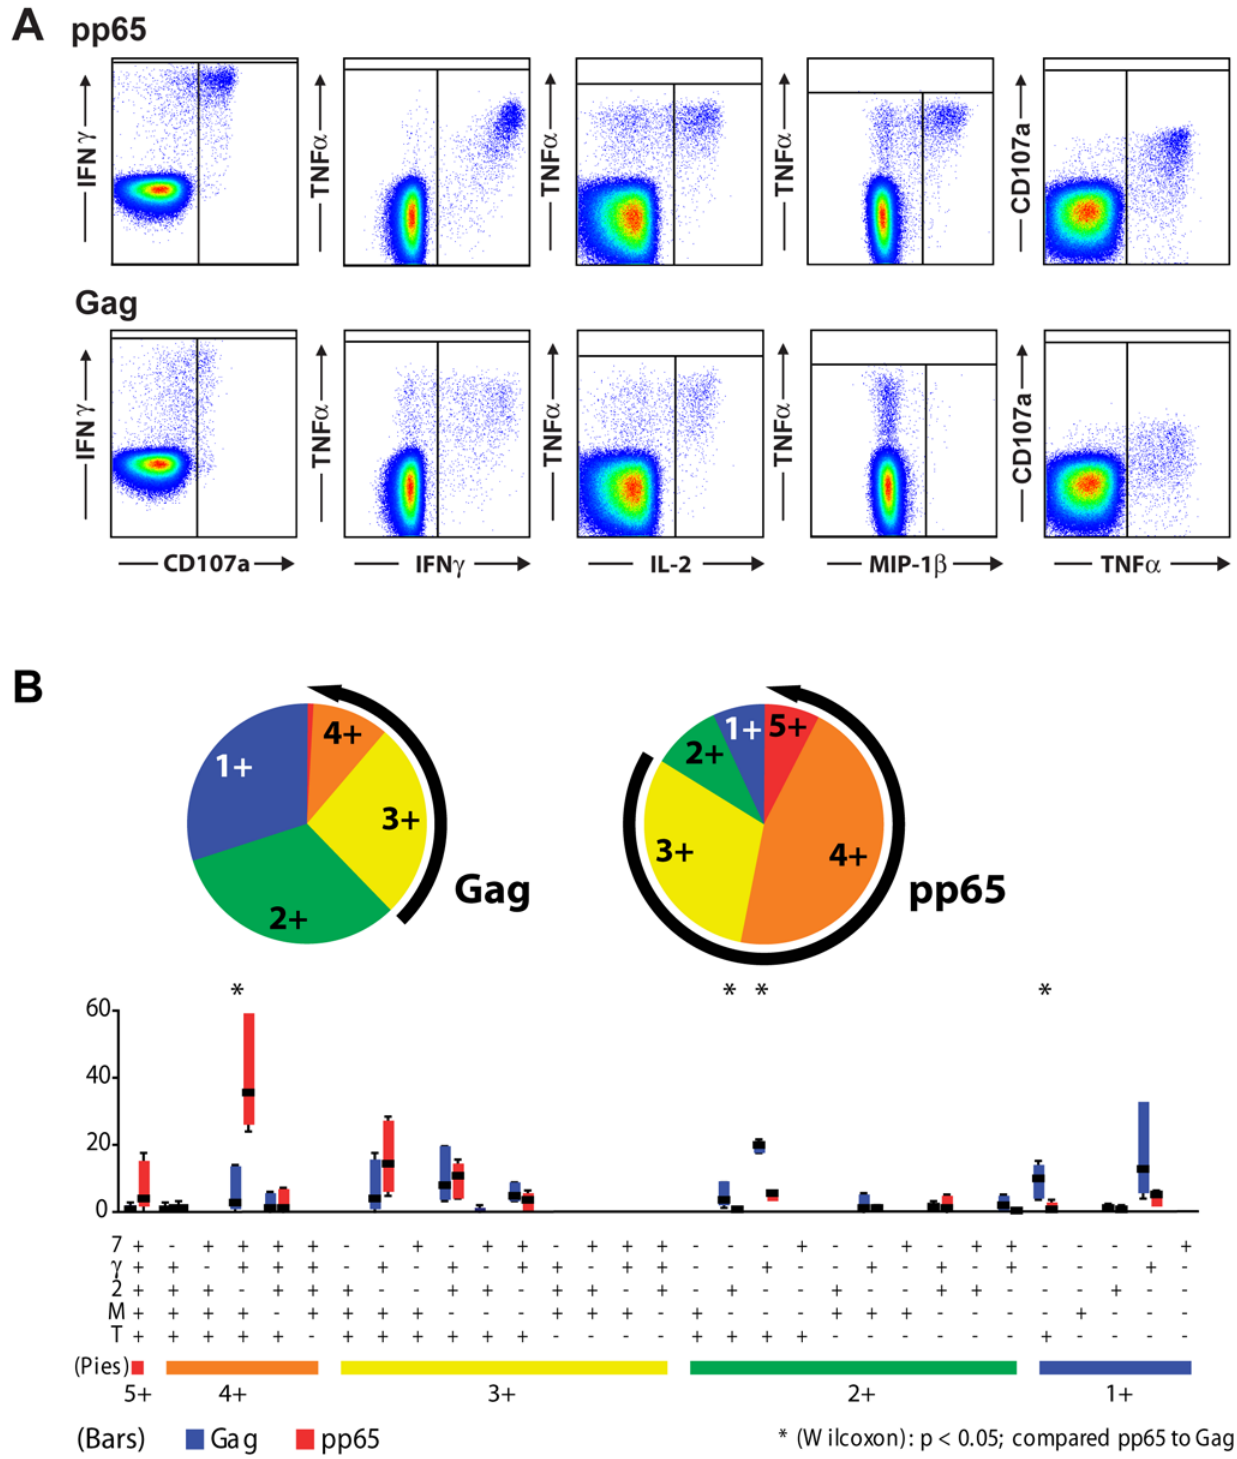
Figure 1. Comparison of polyfunctionality of gag-specific and pp65-specific CD4 + T cell responses. A) Representative plots showing functional responses to pp65 15mers overlapping by 11, and gag 15mers overlapping by 11. B) Individual pie charts show the percentage of antigen- specific CD4 + T cells which produce 1, 2, 3, 4, or 5 functional responses for gag- and pp65-specific CD4 + T cells. Three, four, and five functional responses are highlighted by the black arrows. Polyfunctional responses were significantly more frequent in pp65-specific CD4 + T cells than in gag- specific CD4 + T cells ( P , 0.05). Frequency of functional species for pp65-specific (red bars) and Gag-specific (blue bars) responses are shown in the bar graph for each of the 31 functional species. Colored bars show the range for the 2 nd and 3 rd quartiles, medians are denoted by the horizontal bar and standard deviations are shown by whiskers. Significant differences between the frequencies of different individual gag- and pp65-specific functional species are indicated by a * ( P , 0.05).